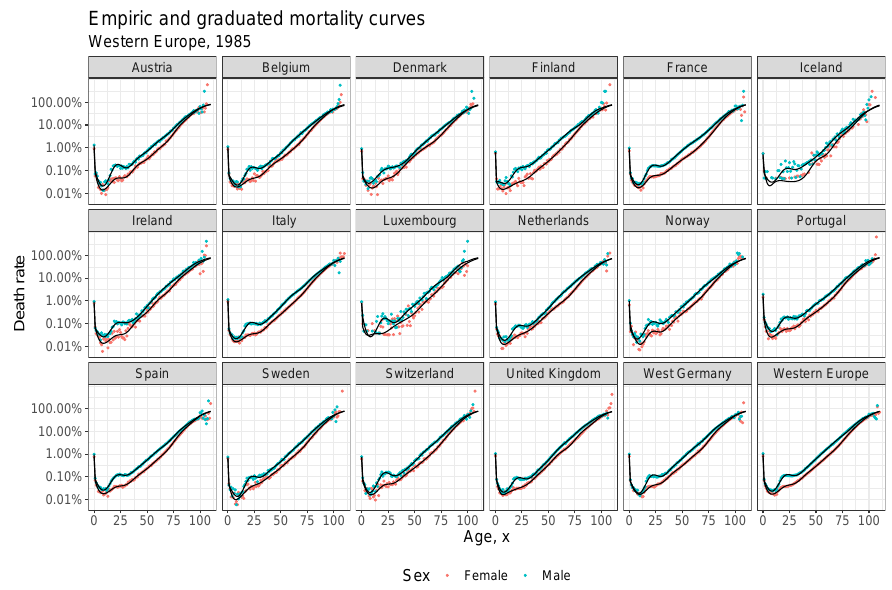
Figure A1. Empiric (dots) and graduated (line) death rates. The graduated mortality curve is computed through